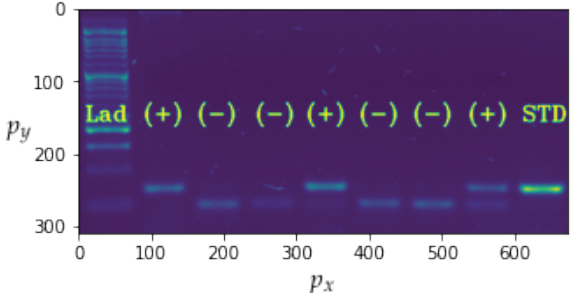
Figure 21. Results of the application of